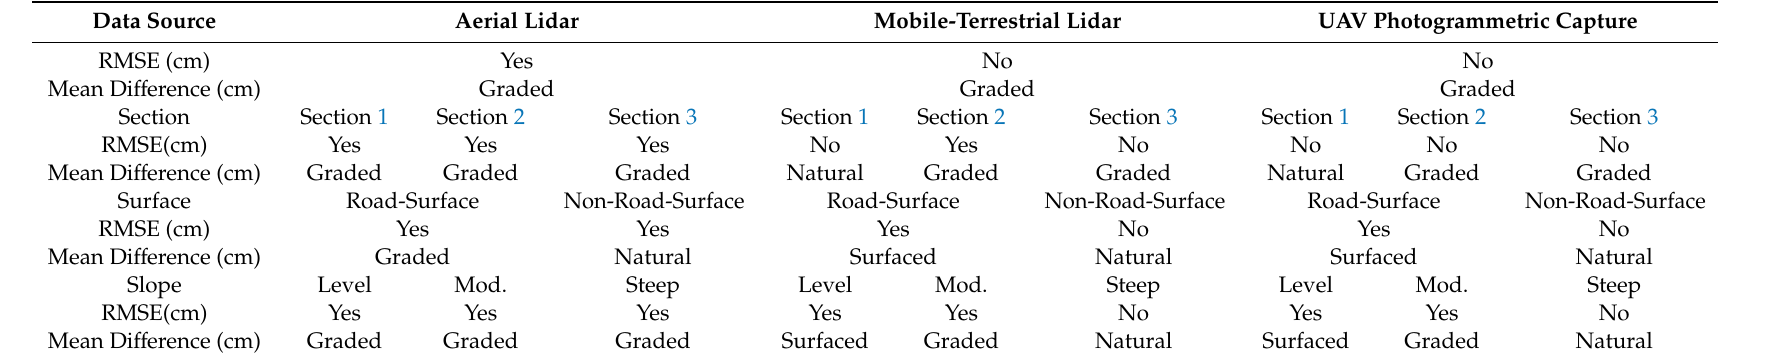
Table 7. Conformance with Available